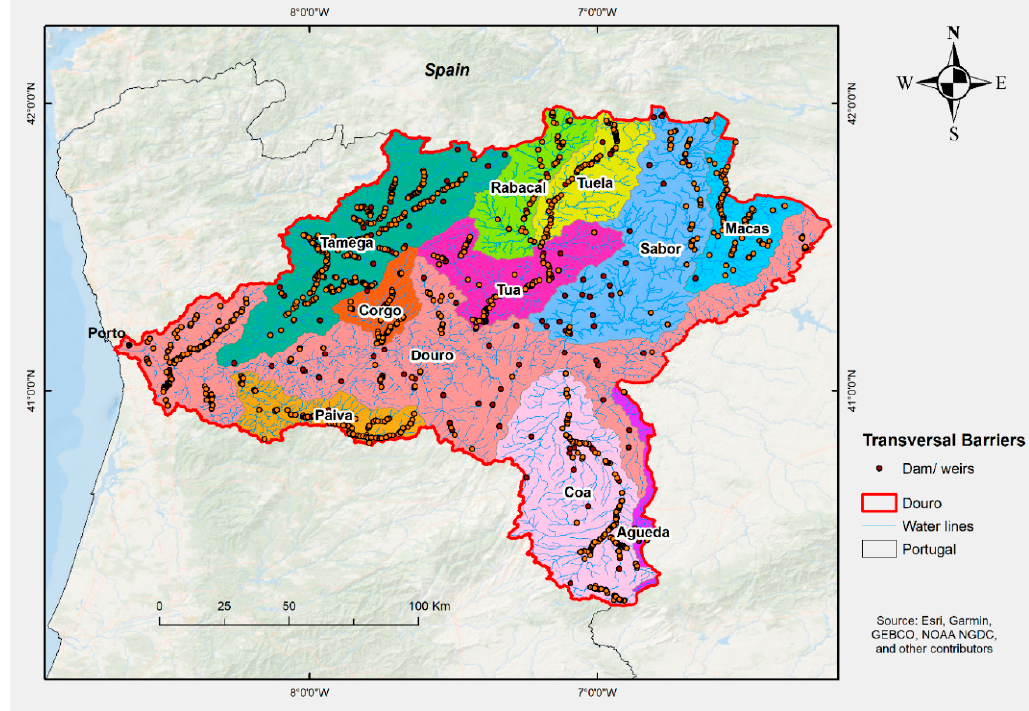
Figure 2. Spatial distribution of barriers within the Portuguese side of the Douro River Basin.